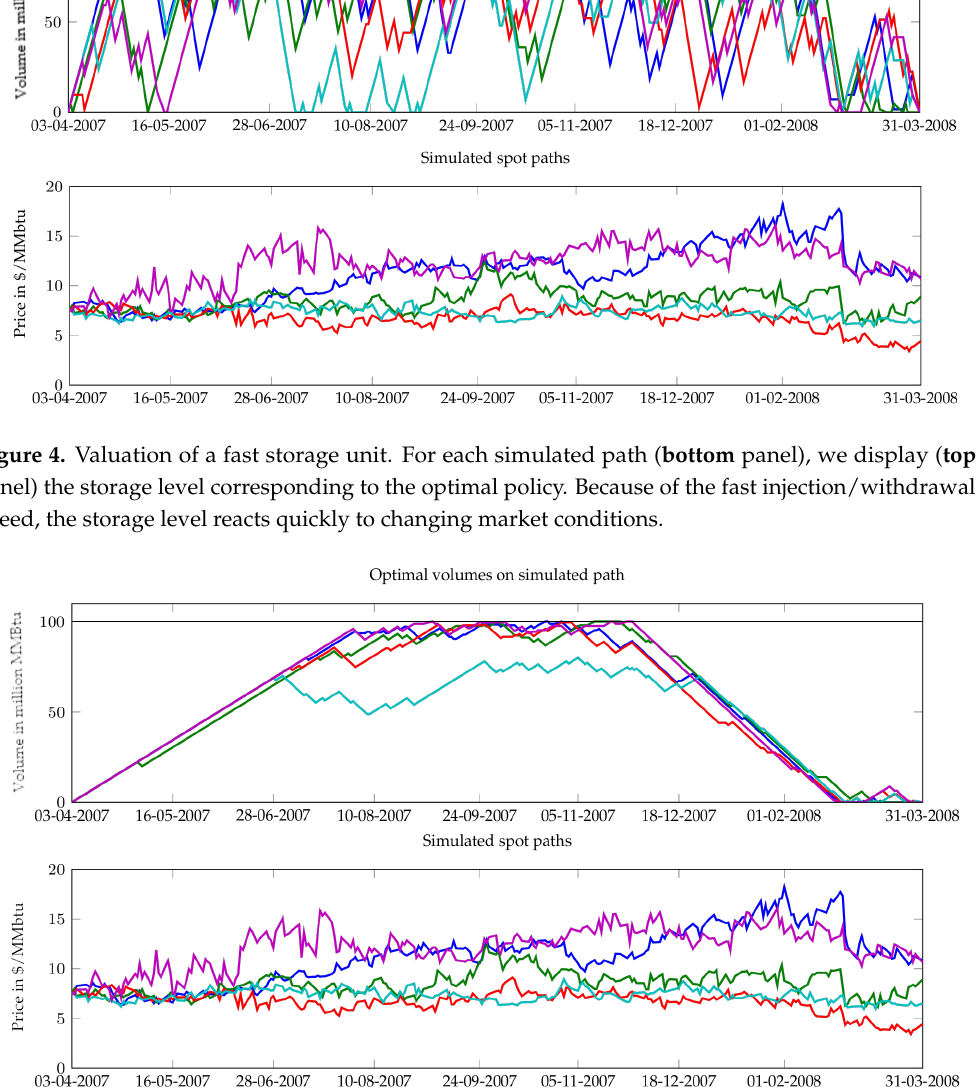
Figure 5. Valuation of a slow storage unit. For each simulated path ( bottom panel), we display ( top panel) the storage level corresponding to the optimal policy. Because of the slow injection/withdrawal rate, there is only one storage cycle per year, and the storage value is essentially function of the summer-winter